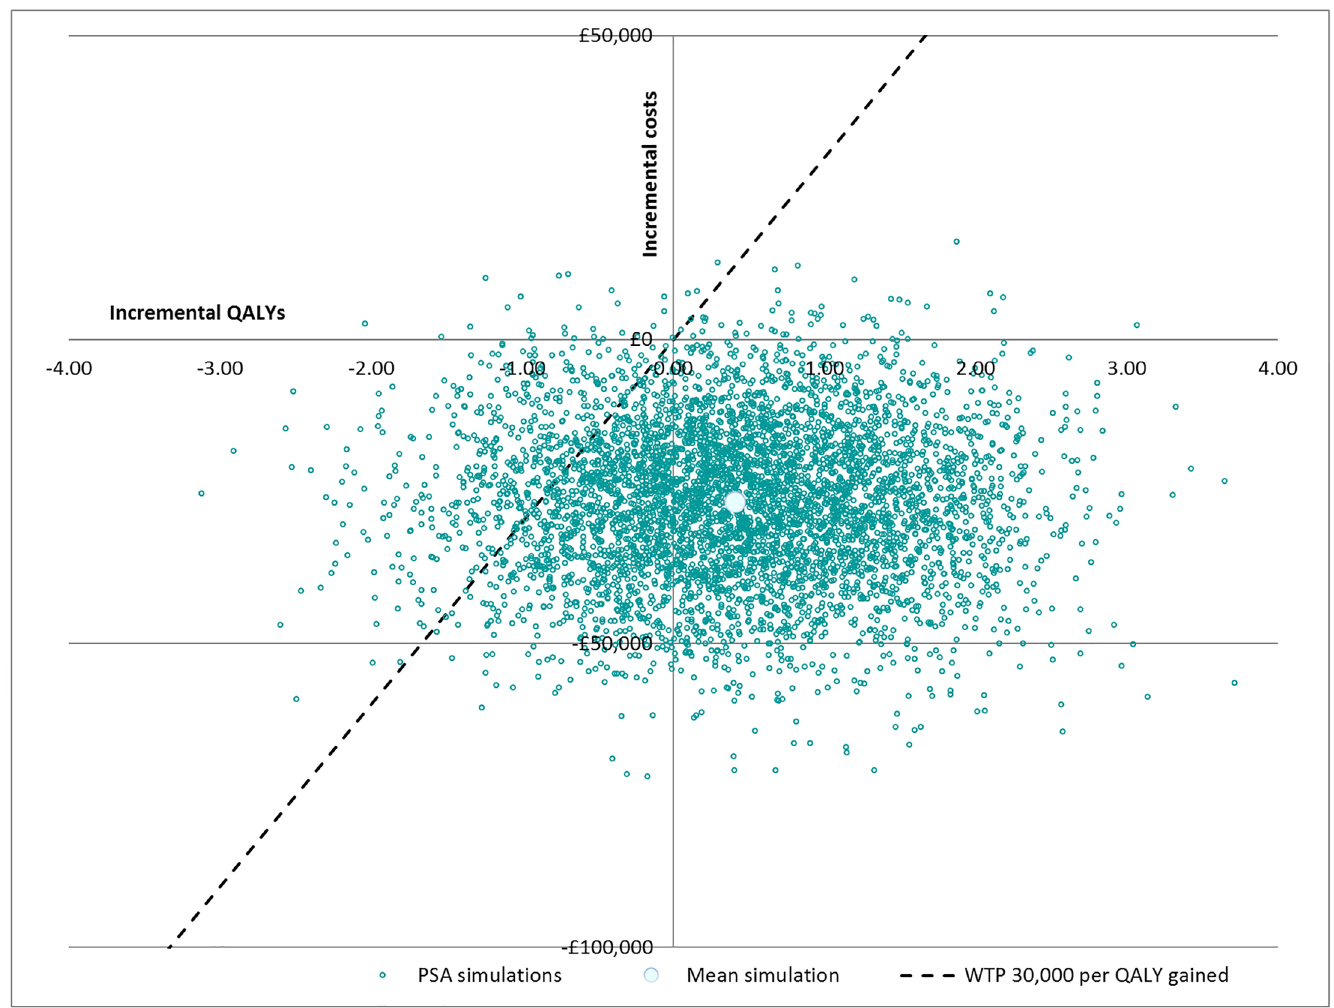
Fig 3. Cost-effectiveness plane. WTP: Willingness to pay: linear threshold corresponds to the WTP value used by NICE in making reimbursement decisions (£30.000 per QALY gained). Each quadrant corresponds to one incremental cost option (cost saving, not cost saving) and one incremental benefit option (more/less benefit than comparator